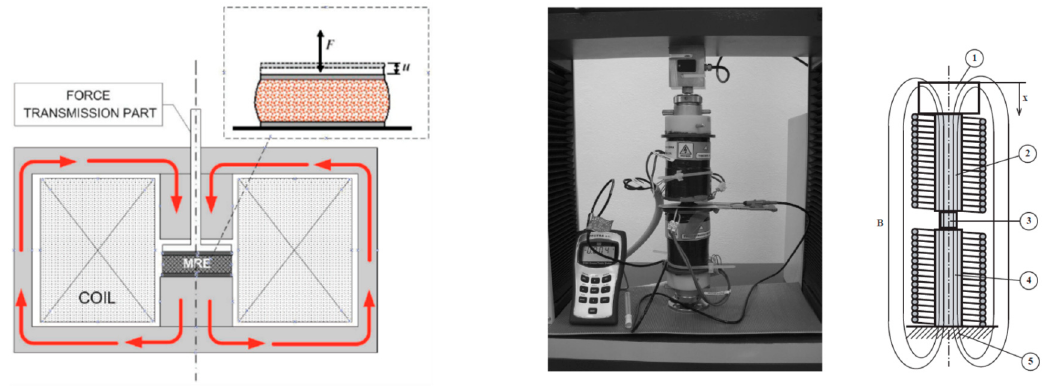
Figure 5. A static model of operation in squeeze form of deformation of MRE during compression with the magnetic domain. Reprinted from [19] © 2005 and [20], 2016 with permission from Elsevier.